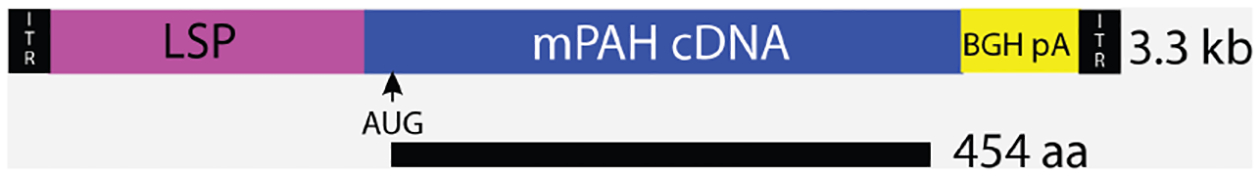
Representative recombinant AAV vector genome for liver-directed gene therapy for PKU.Diagram of a typical recombinant AAV vector genome designed for liver-directed gene therapy in Pahenu2/enu2 mice. Expression from the murine PAH complementary cDNA (cDNA) is driven by a strong Liver Specific Promoter (LSP). A canonical polyadenylation signal from the bovine growth hormone gene (BGH pA) is also required for appropriate expression. The only viral sequences retained the in genome are the two AAV intermediate terminal repeats (ITRs) flanking the expression cassette; these sequences are necessary for packaging of the genome into viral capsid proteins to form infectious viral particles and for the appropriate intracellular processing of the genomes following vector administration. The translation start site (AUG) is depicted at the 5’ end of the cDNA; translation initiated here yields a functional 454 amino acid PAH monomer that then spontaneously forms enzymatically active tetramers.